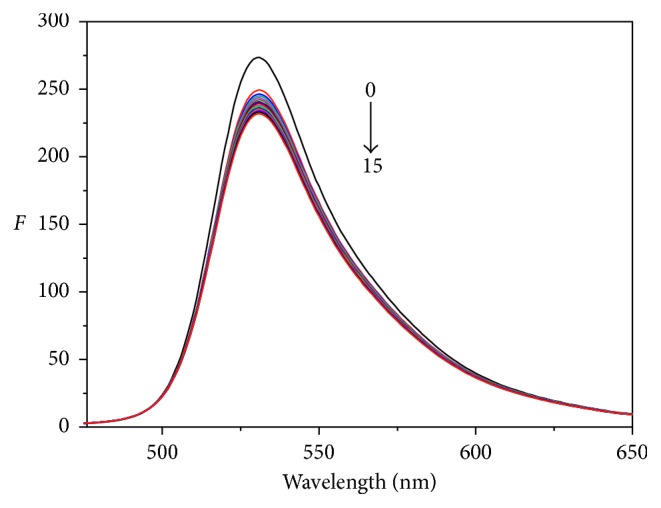
Emission spectra of hsDNA-AO mixture in different concentrations of Cu-bipy (pH = 7.40, λex = 411.7 nm). From curves 0–15, c(hsDNA-AO) = 1.0 × 10−5 mol·L−1; c(Cu-bipy) = 0.00, 0.33, 0.67, 1.00, 1.33, 1.67, 2.00, 2.33, 2.67, 3.00, 3.33, 3.67, 4.00, 4.33, 4.67, and 5.00 × 10−6 mol·L−1, respectively.